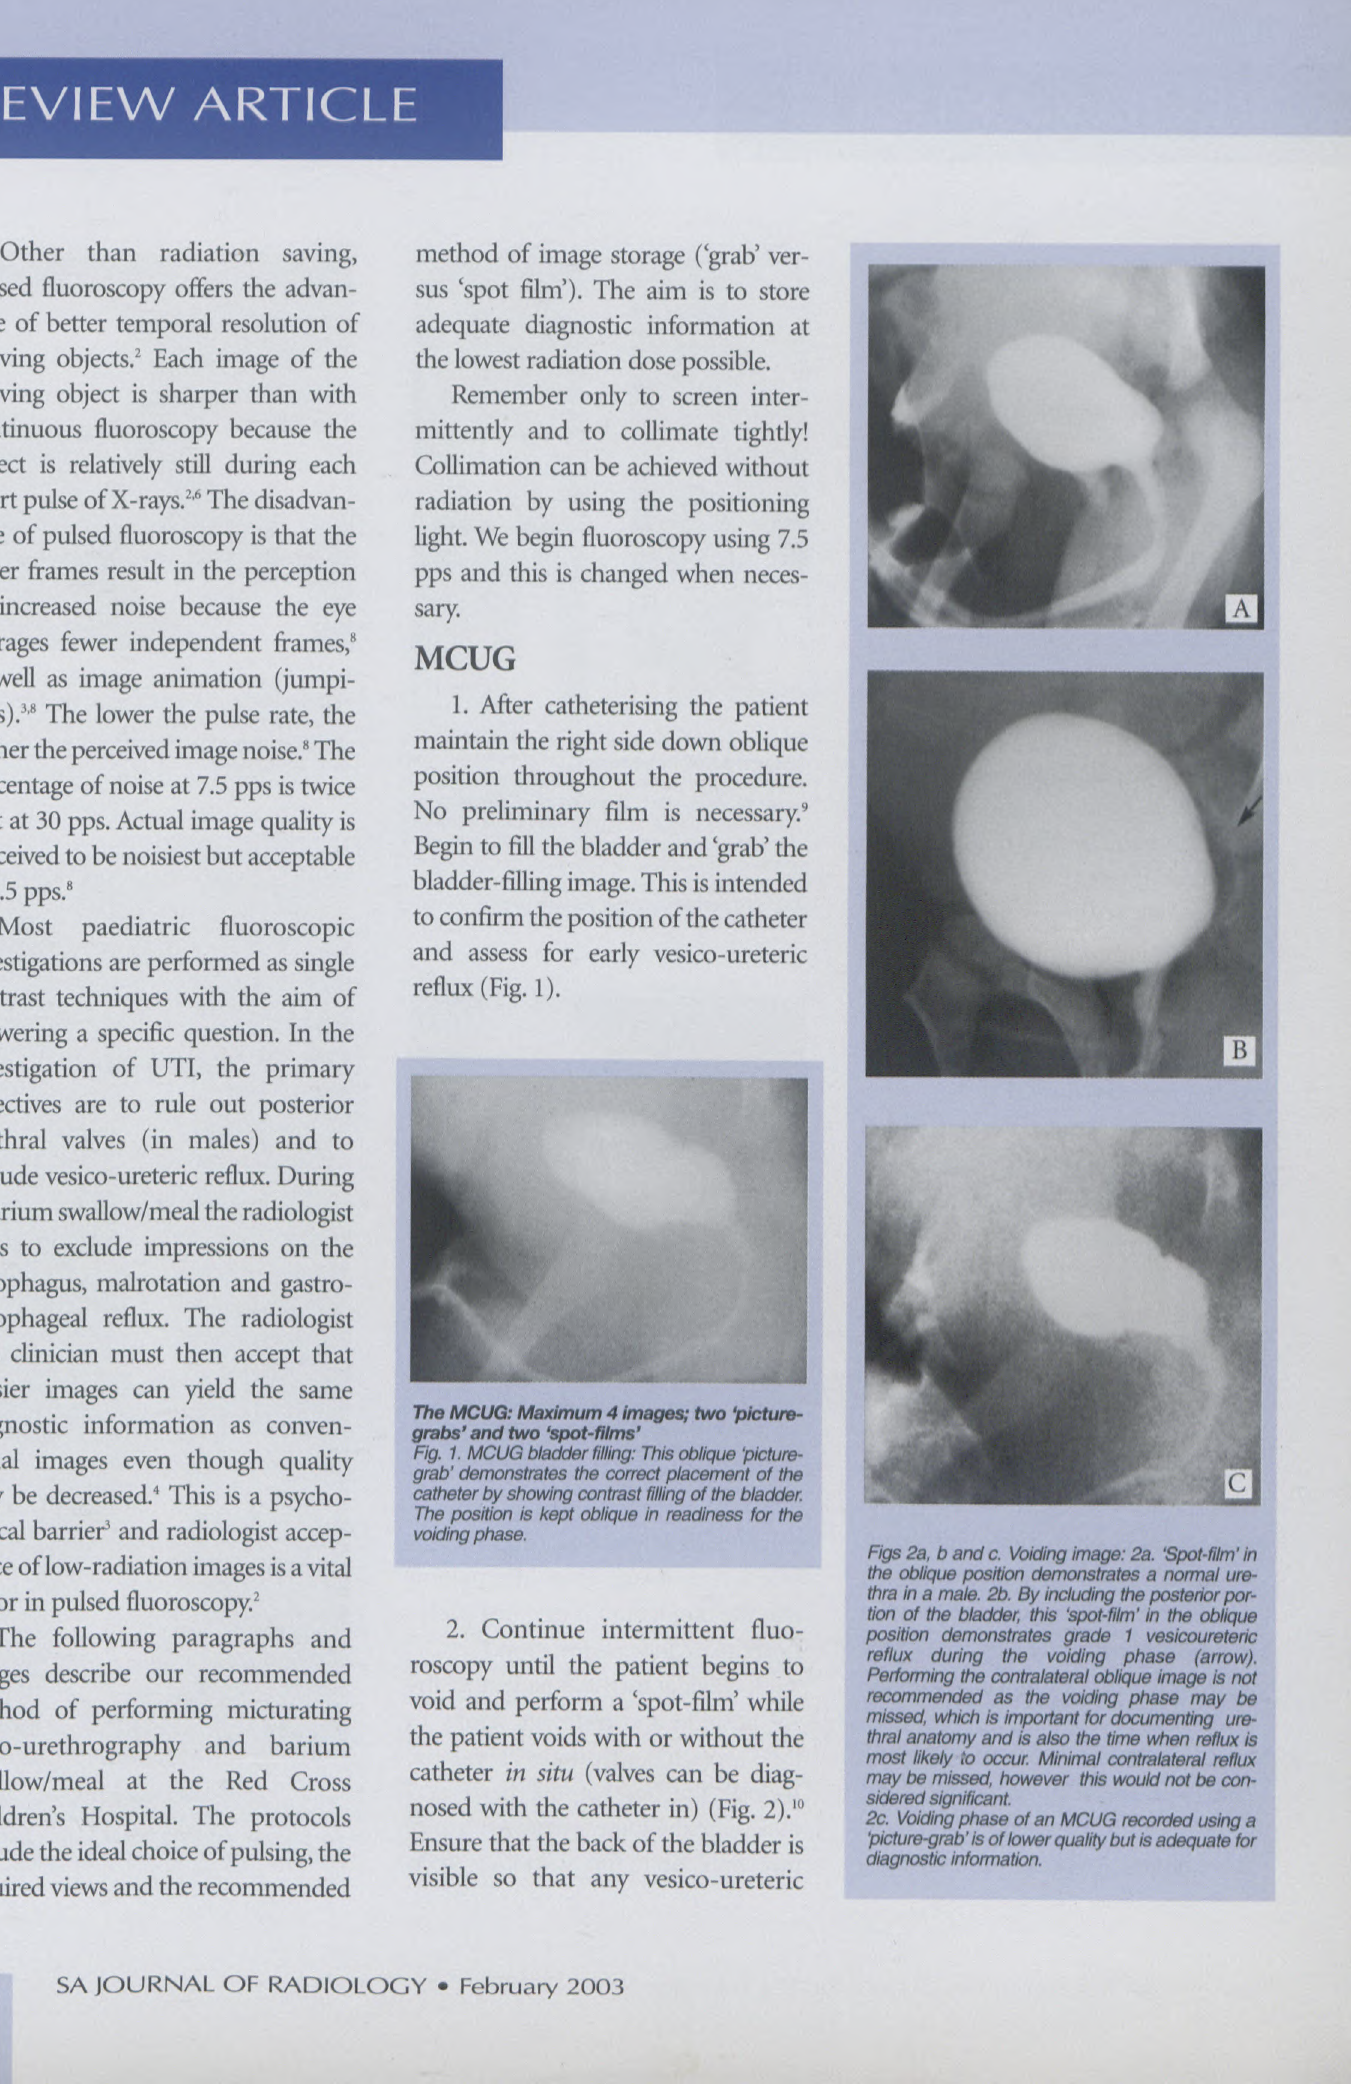
Figs 2a, b and c. Voidingimage: 2a. 'Spot-film'in the oblique position demonstrates a normal ure- thra in a male. 2b. By including the posterior por- tion of the bladder, this 'spot-film' In the obI/que position demonstrates grade 1 vesicoureteric reflux during the voiding phase (arrow). Performing the contralateral oblique image is not recommended as the voiding phase may be missed, which Is impoltant for documenting ure- thral anatomy and is also the time when reflux is most likely ro occur. Minimal contralateral reflux may be missed, however this would not be con- sidered significant. 2c. Voidingphase of an MCUG recorded using a 'picture-grab'is of lower quality but is adequate for diagnostic